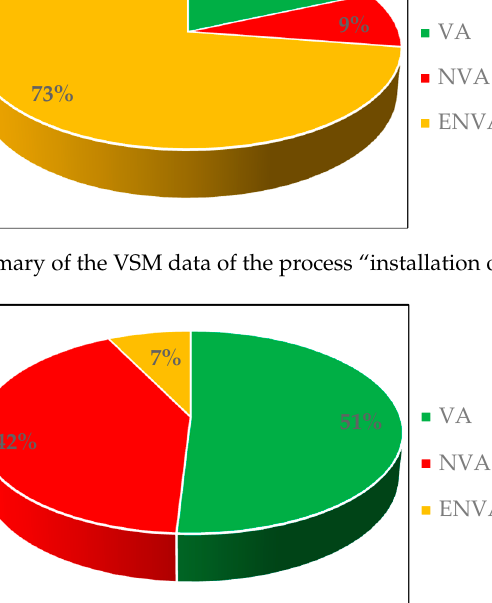
Figure 5. Summary of the VSM data of the process “painting of a wall”.